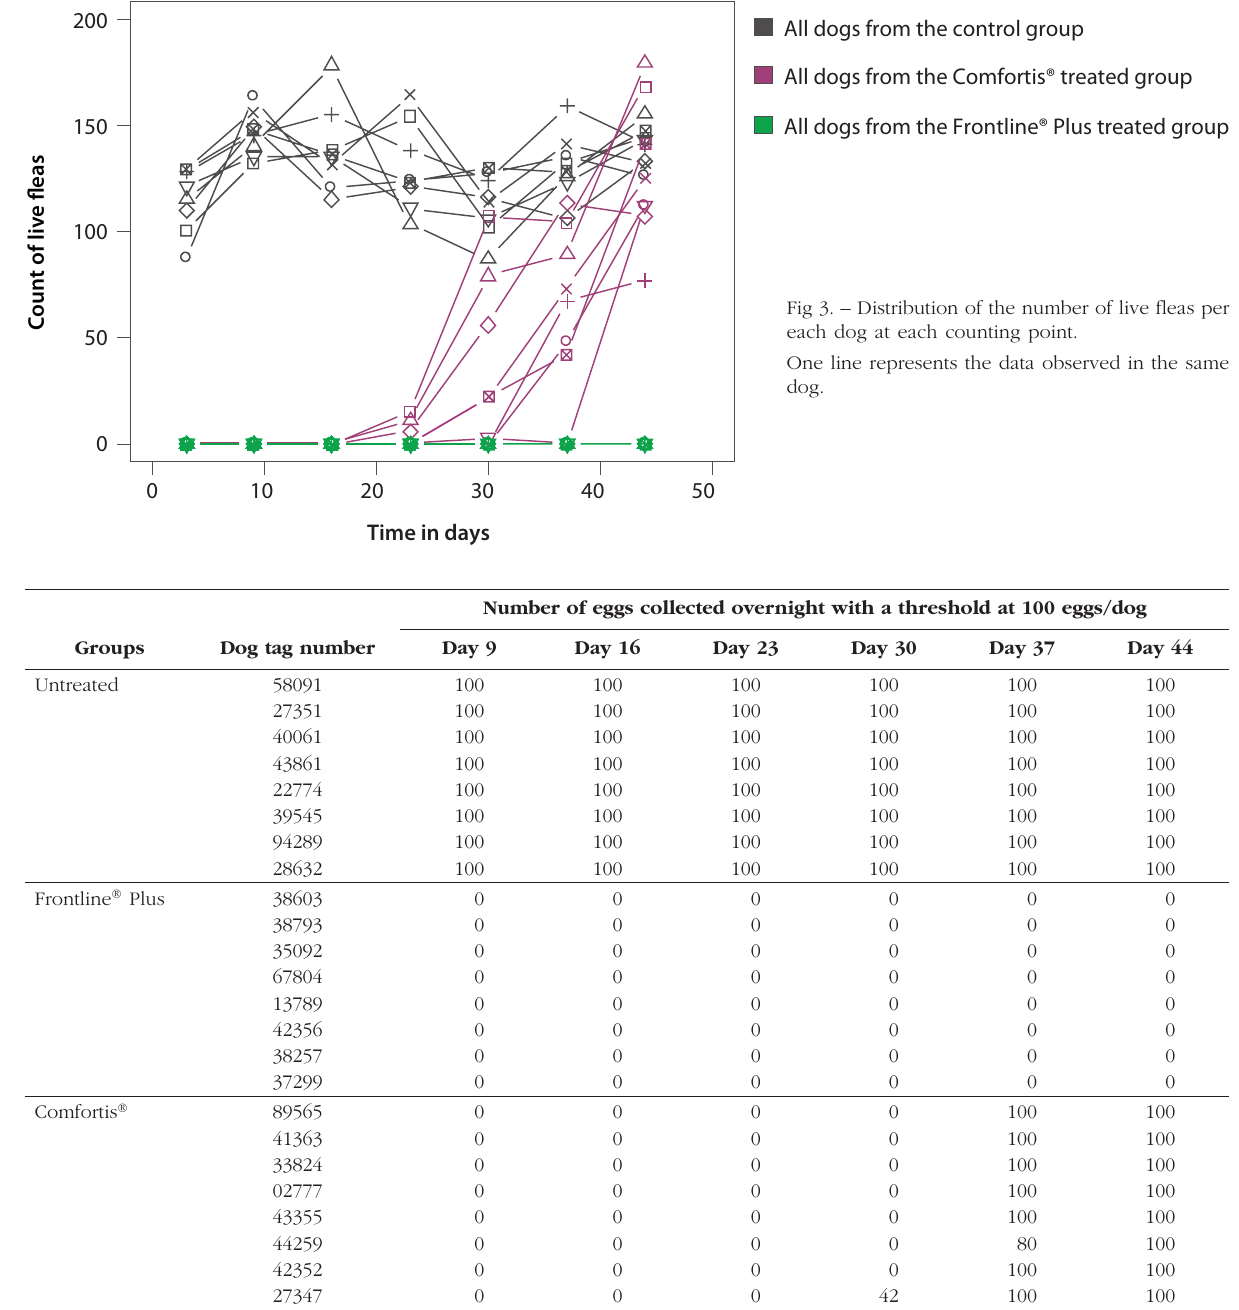
Table IV. – Number of egg collections overnight per each dog from Day 9 to Day 44.